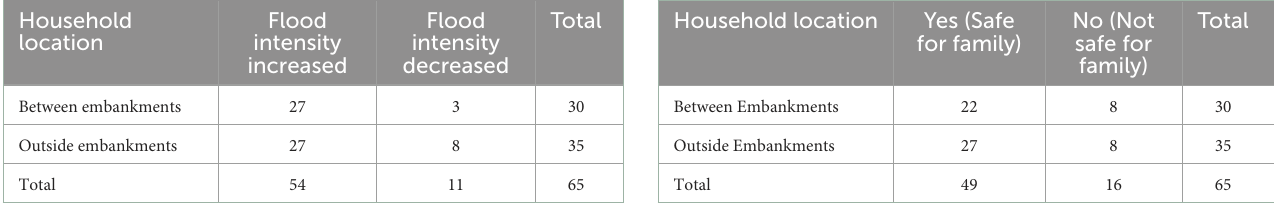
TABLE 6 The cost of raising land in selected study villages based on their location. Total annual cost (Between